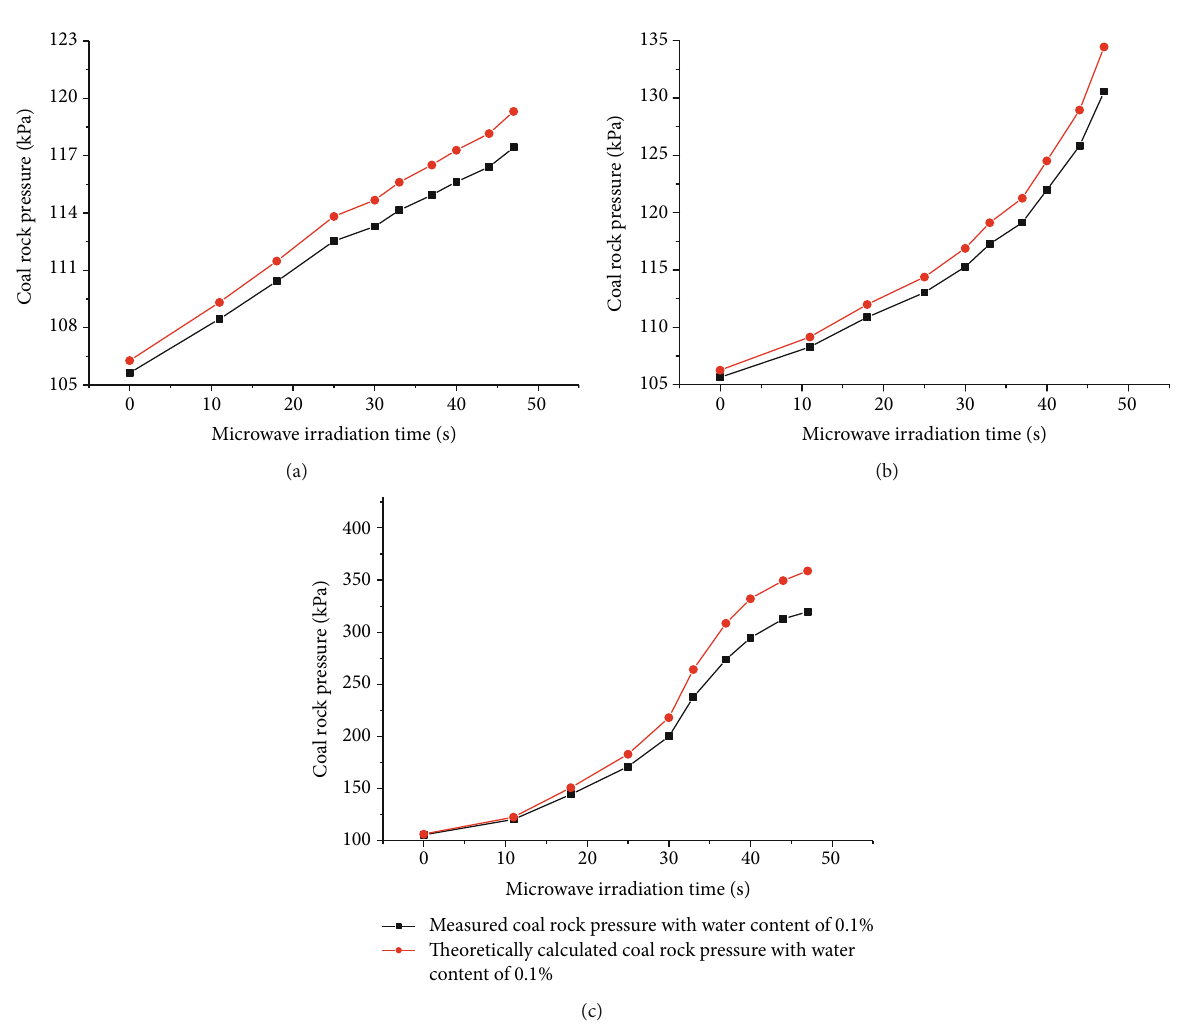
Figure 7: Comparison of calculated and tested vapor pressure values under di ff erent water contents: (a) 0.1%, (b) 2%, and (c)